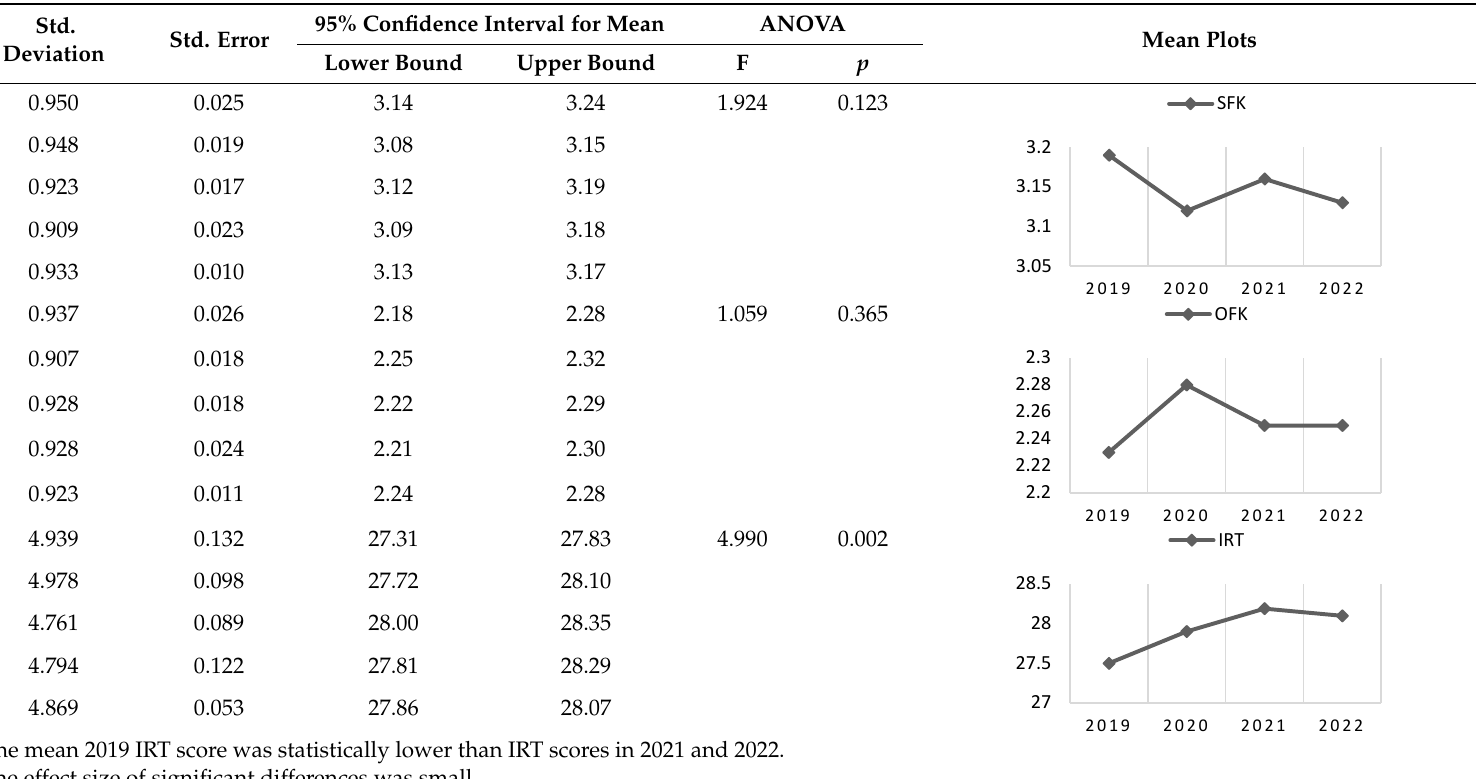
Table 2. Descriptive Statistics for financial knowledge and investment risk tolerance. (N = 8038).